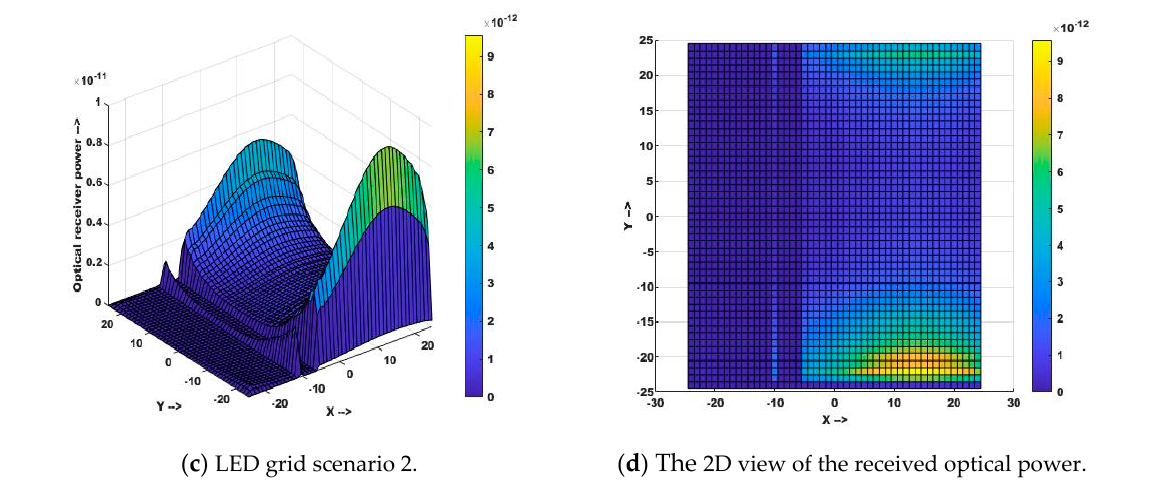
Figure 5. Proximity of light sources.